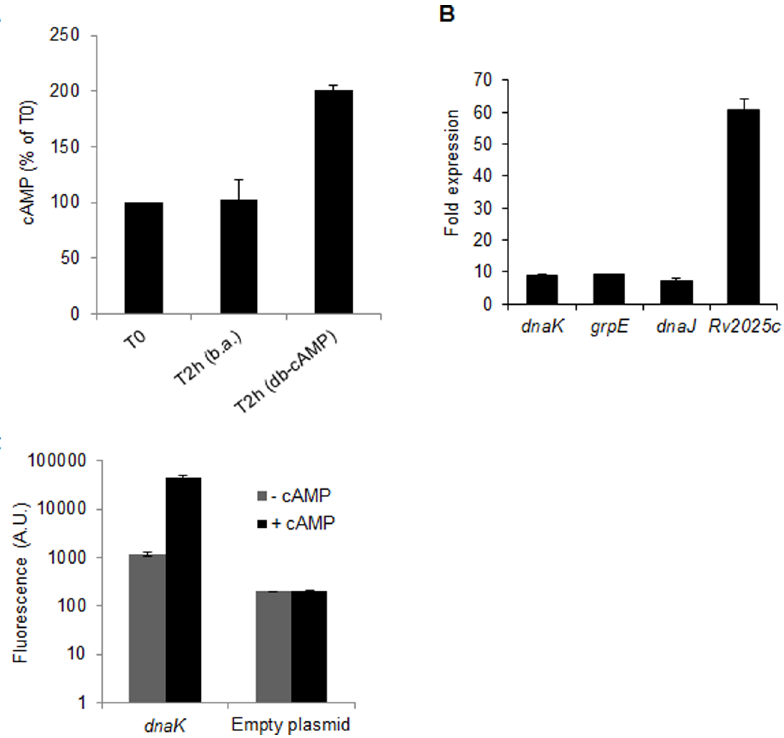
Figure 3. Effect of cAMP on global gene expression profile of Mtb. A) Effect of db-cAMP treatment on intracellular cAMP levels in Mtb. In vitro grown cultures of Mtb were treated with 20 mM butyric acid (b.a.) or db-cAMP for 2 hrs, followed by intracellular cAMP estimation by ELISA. Shown are the intracellular cAMP levels after 2 hrs of treatment (T2h) compared to that in untreated cells at zero hour time point (T0). B) Validation of differential expression of genes in microarray analysis by qRT-PCR. Genes upregulated in the db-cAMP-treated Mtb relative to the butyric acid-treated sample by microarray analysis were evaluated by qRT-PCR. The fold-expression indicates the ratio of sigA -normalized gene expression levels in the db-cAMP-treated strain relative to those in the butyric acid-treated Mtb. C) Effect of db-cAMP on in vivo activity of dnaK promoter. In vivo activity of dnaK promoter was assessed by measuring b -gal expression in Msm harboring pSD5B- dnaK ( dnaK ) using b -gal fluorescent substrate (C2FDG). Promoter activity was determined in mycobacterial cultures treated with 10 mM db-cAMP ( + cAMP) or butyric acid (-cAMP) for 2 hrs. The empty plasmid pSD5B was used as a control. Data represent an average of three independent experiments and error bars indicate standard deviations.